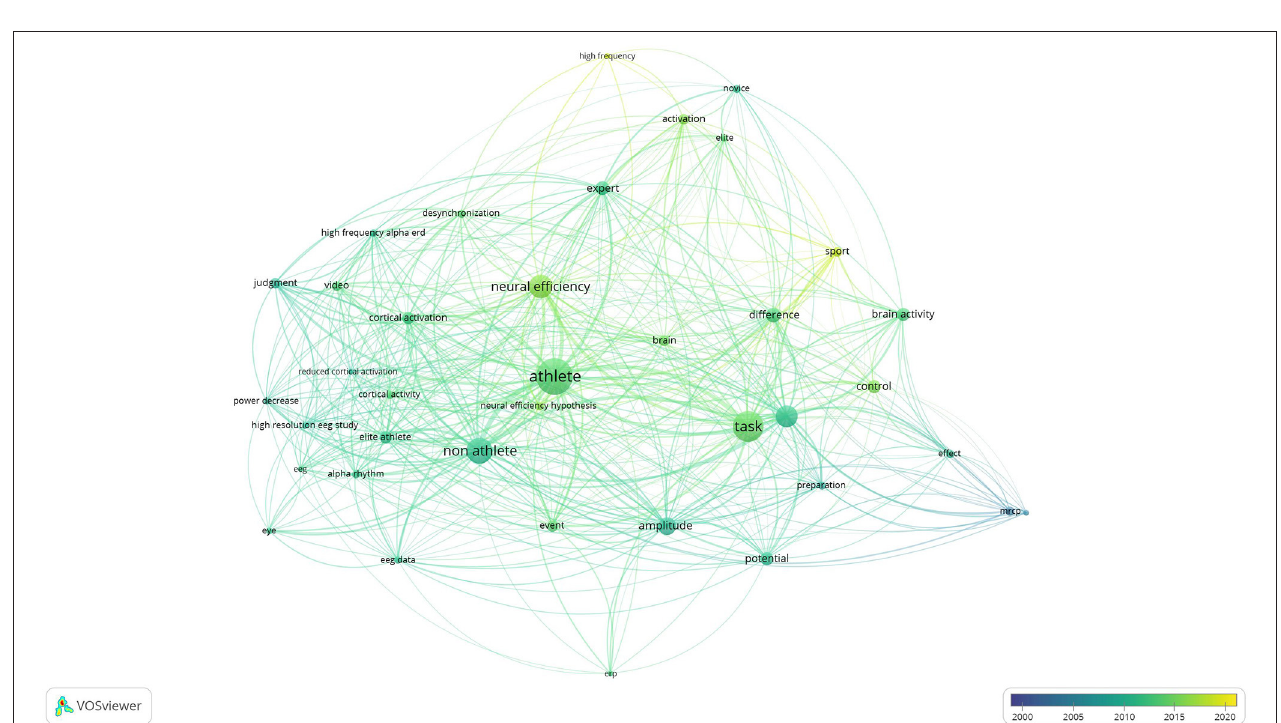
FIGURE 4 | Co-occurrence map and key terms of selected studies.